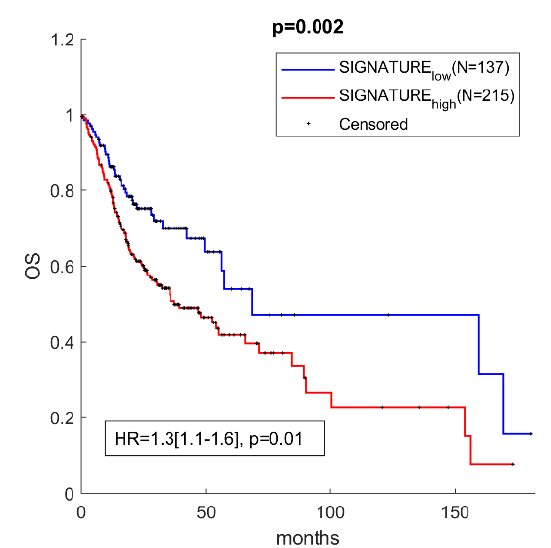
Figure 3. High expression of miR-30c-5p targets had prognostic value in patients with OSCC. Kaplan–Meier analysis representing the correlation between expression levels of miR-30c-5p targets considered as a group and OS in OSCC patients from the TCGA cohort. The TCGA cohort was divided in two subgroups according to positive and negative z-scores of the mean expression level of each prognostic mRNA. For each KM curve, the hazard risk, confidence interval, and relative p -value ( p ) of the multivariate Cox analysis are also indicated.